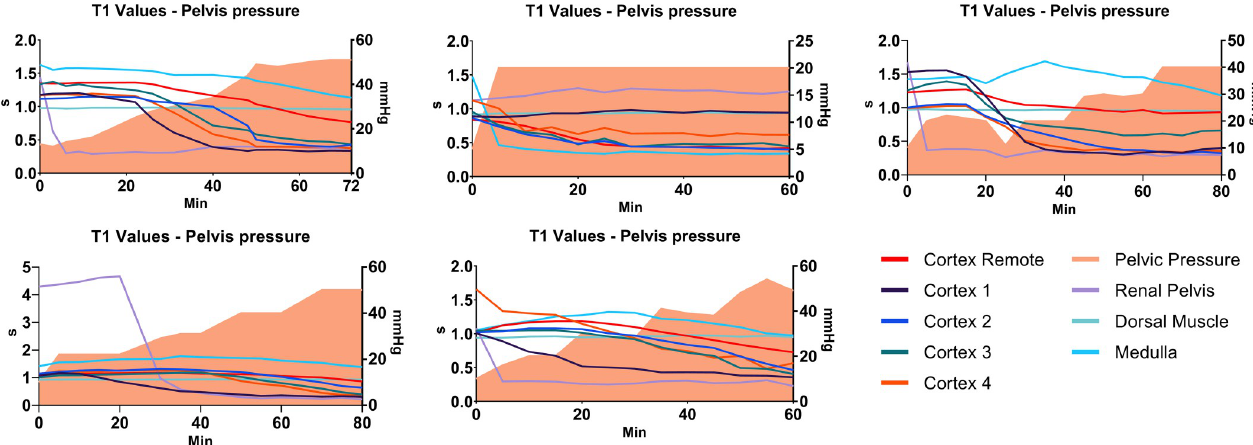
Fig 8. T1 vs pelvis pressure. The development of T1 with increasing pressure was assessed by placing ROI’s in different segments of the treated kidneys, and plotting T1 as function of time/pressure. Left vertical axis: T1; right vertical axis: pressure; horizontal axis: time. Each graph represents the treated kidney of each of the 5 animals. Cortex remote: visibly non-affected area; cortex 1–4: visibly affected areas; renal pelvis; medulla and dorsal muscle ROIs depicted by lines. Pressure at a given time depicted by colour filled area under the curve. T1 values in affected areas decrease as a function of increasing pressure/time.